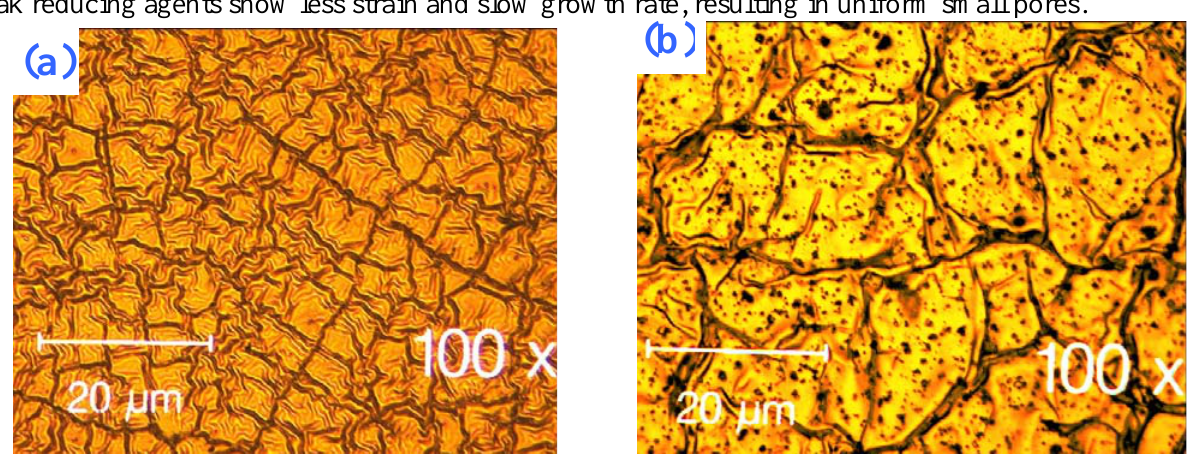
Figure 3 . Optical micrograph of Pt electrode deposited on Nafion117 membrane using ) Cl and reductant concentration (a) 0.01 M NaBH 0.01 MPt(NH 3 4 2